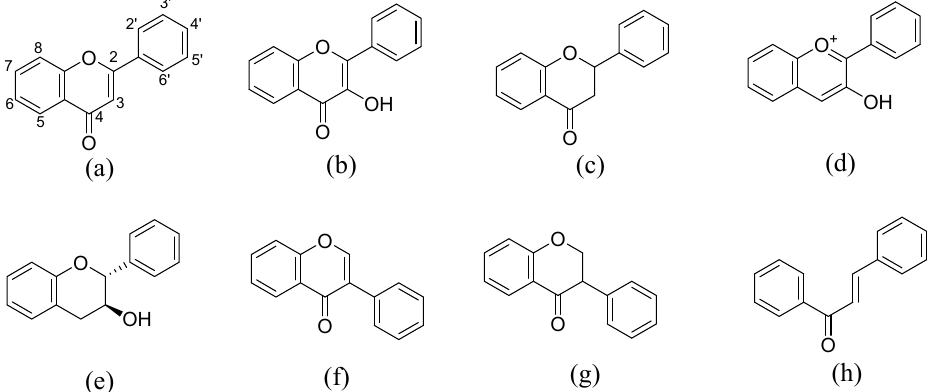
Figure 1. Structures of ( a ) flavone, ( b ) flavonol, ( c ) flavanone, ( d ) anthocyanidins, ( e ) flavan-3-ols, ( f ) isoflavone, ( g ) isoflavanone and ( h ) chalcone.